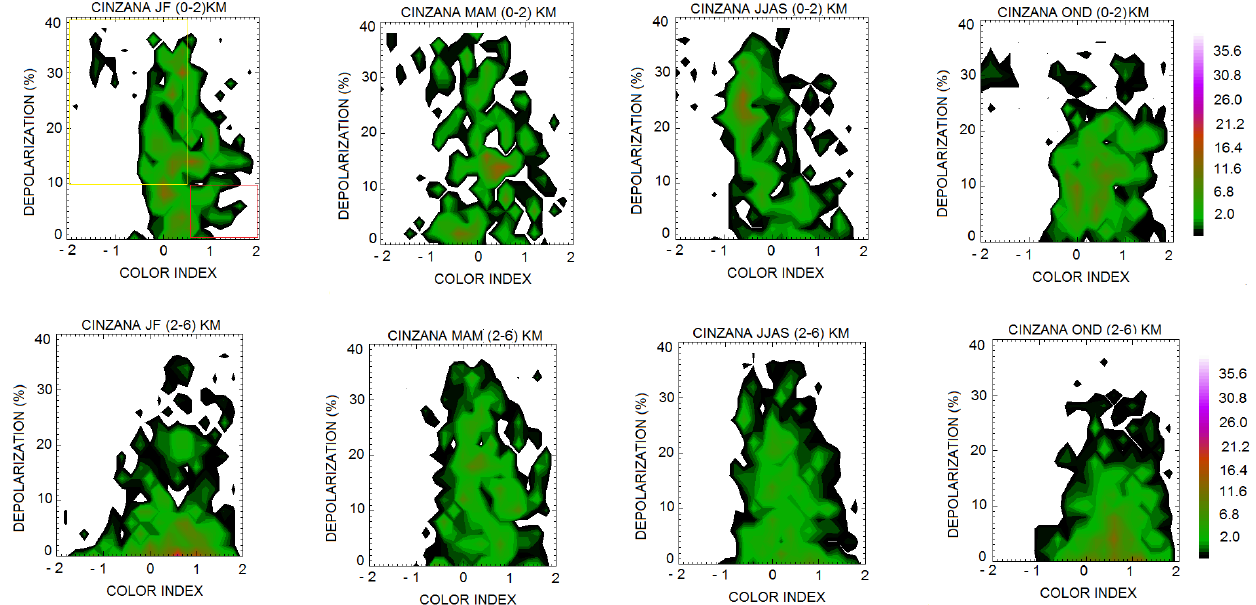
Fig. 6. Joint PDF for Color Index and Depolarization retrieved from CALIOP observations for different seasons over the Cinzana site. Column 1–4 show the data for the months January-February (JF), March-April-May (MAM), June-July-August-September (JJAS) and October-November-December (OND), respectively. The upper row shows results for the boundary layer (0–2)km while the lower row corresponds with the troposphere (2–6)km. Using the criteria specified in Table 4, in the upper left subplot yellow and red rectangles identify, respectively, desert dust and biomass burning aerosols. The same rectangles also apply to the other panels.